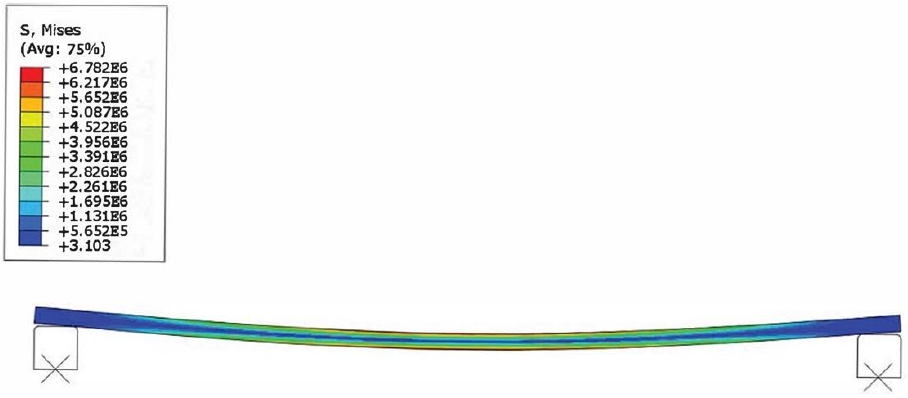
Figure 3. Plot of the equivalent Von Mises stress (Pa) of the pallet analog under uniformly distributed loading of 4.14 kPa.